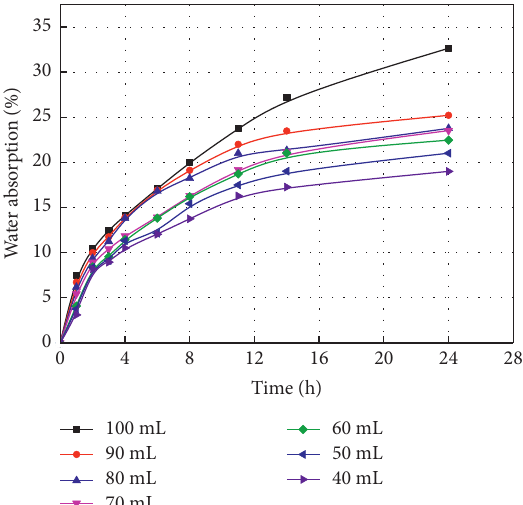
Figure 13: Water absorption of foamed concrete prepared with different volumes of foaming agent